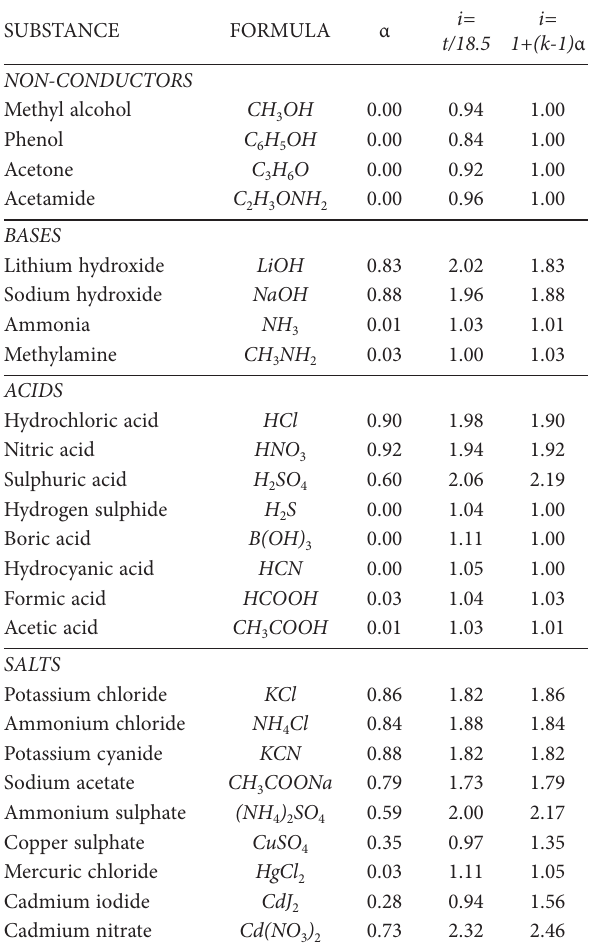
Table 4. Comparison of the van ´t Hoff factors, i , for dilute aqueous solutions of non-conductors, bases, acids and salts, derived from Raoult´s freezing point depression, t (column 4) and from its rela- tion to the degree of dissociation, α, as given in the above text (col- umn 5). α was measured from the ratio of the conductivities of the dilute solution and those at limiting conditions. Temperature t is in °C. The paper lists a total of 90